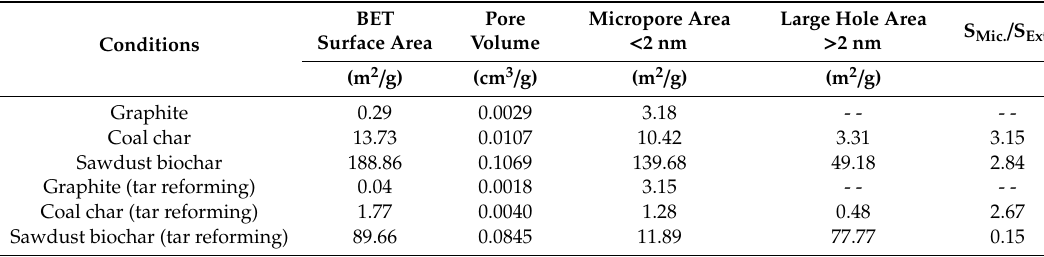
Table 1. N 2 adsorption parameters of three char-based